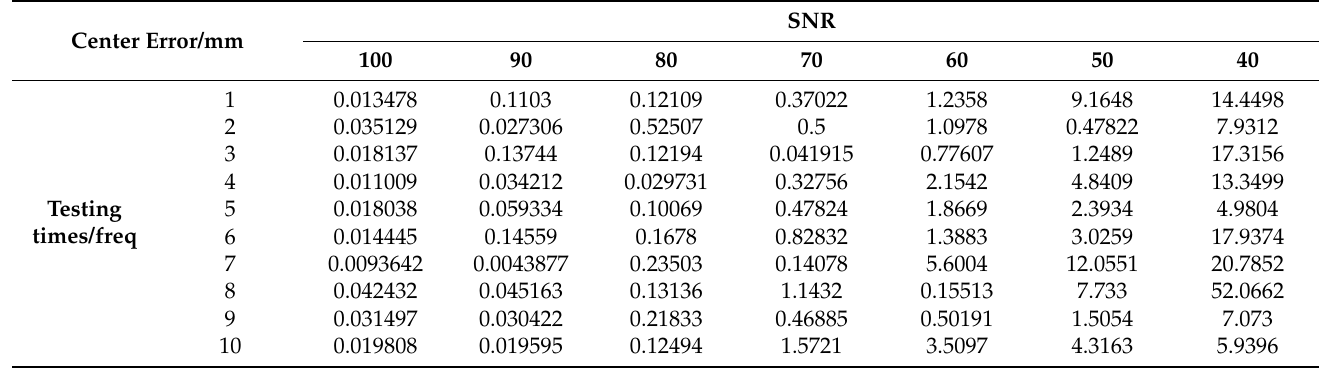
Table 4. Target center error results of image elliptical edge points with